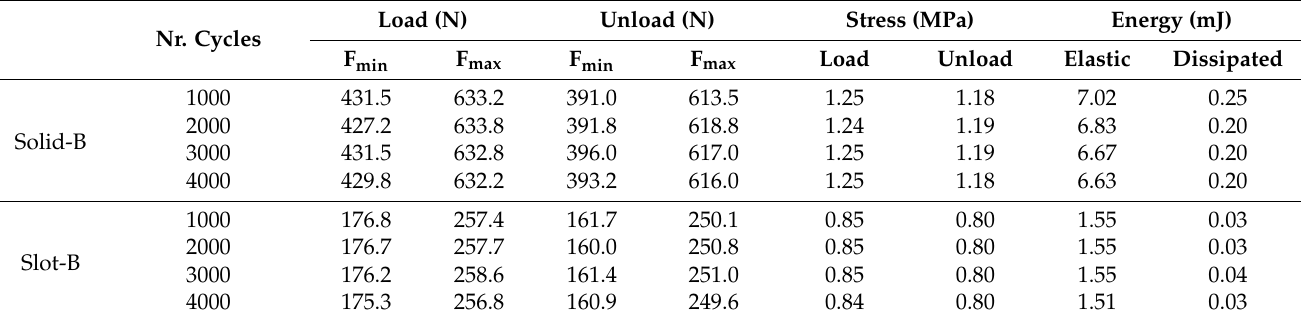
Table 3. Average values of Solid-B and Slot-B mortar samples during the cyclic load test (values obtained from the central stretch of the hysteresis